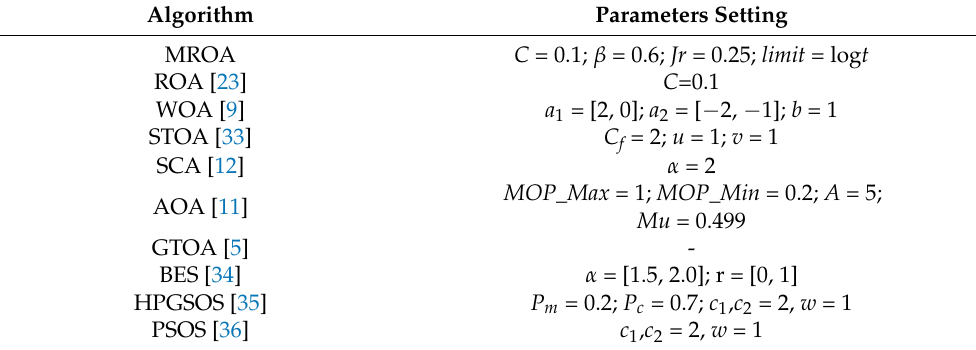
Table 1. Parameter setting of each algorithm.